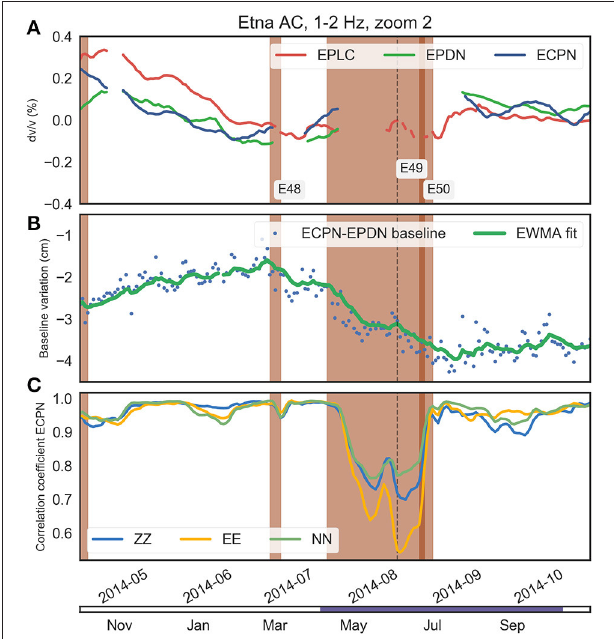
were equal to 0.3, 0.4, and 0.7 km for longitude, latitude,